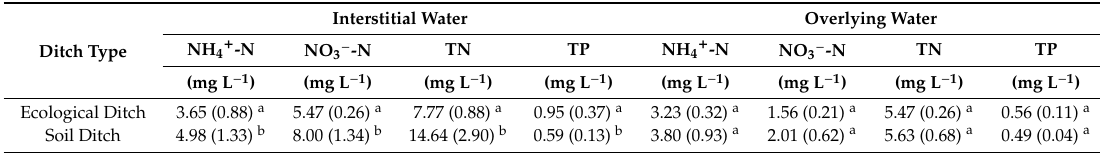
Table 1. E ff ect of ditch types on water quality parameters of interstitial water and overlying water of